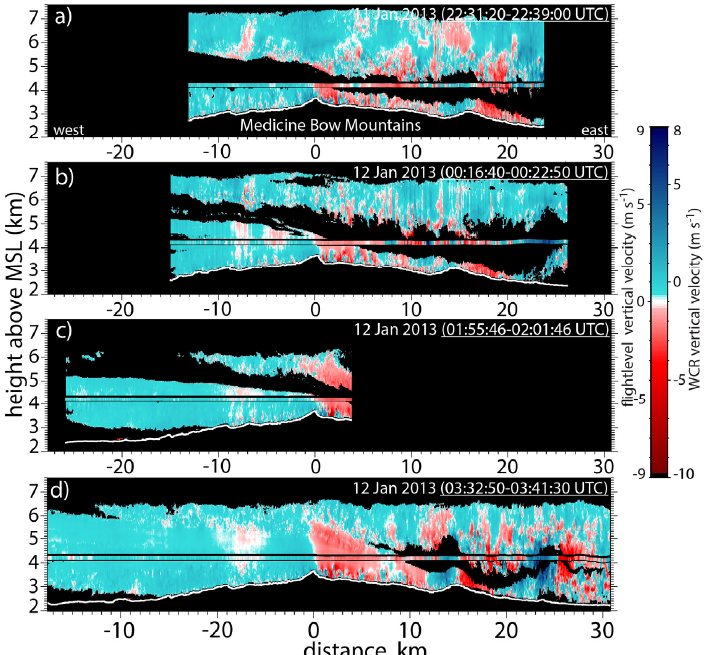
Figure 11. As in Figure 8, but for WCR measured hydrometeor vertical velocity. Also shown, at flight level, is the gust probe vertical air velocity. Note that the color bar is centered at 0 m s − 1 for the gust probe, yet at –1 m s − 1 for the WCR. This is intended to allow for interpretation of WCR data as air vertical motion. vertical